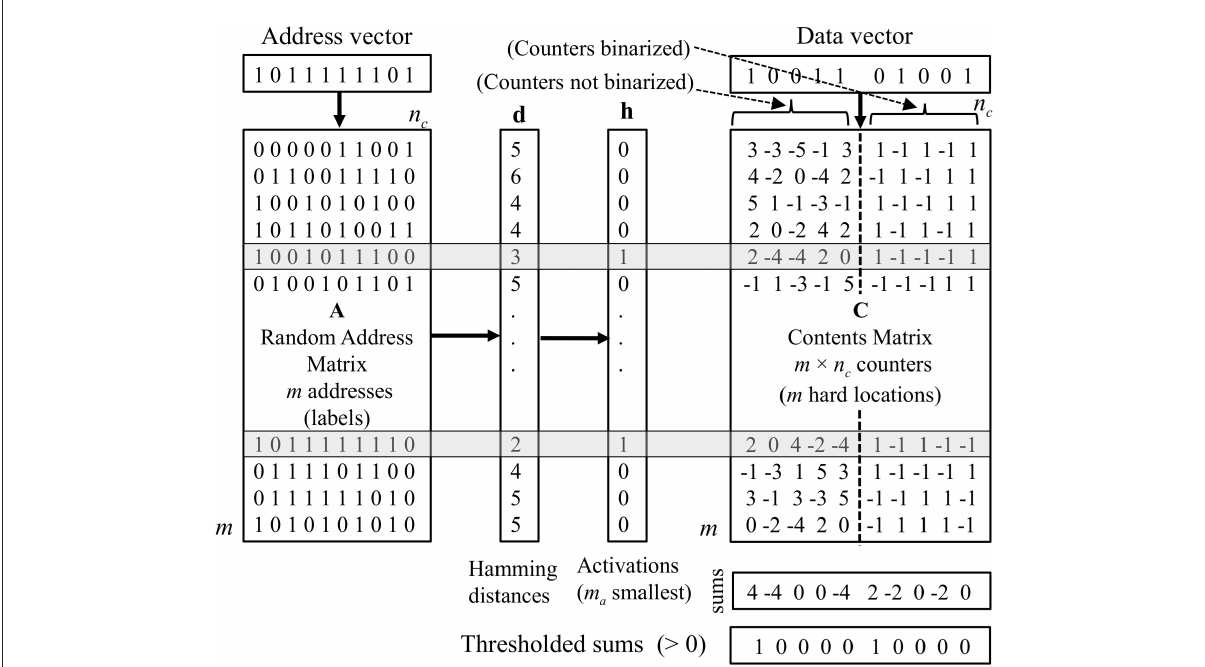
FIGURE1 An outline of the organization of the SDM. The memory locations activated for storage or recall phases (shaded rows) are those with the smallest Hamming distance between the address vector and addresses (labels) in the address matrix. To store data, counters in the activated rows (hard locations) in the contents matrix are incremented or decremented according to the bits in the data vector. For variations A2 and A3 the counters are binarized before recall. The recall is done by column-wise superposition (adding) the counters in activated rows and thresholding at zero for variations A1 and A2